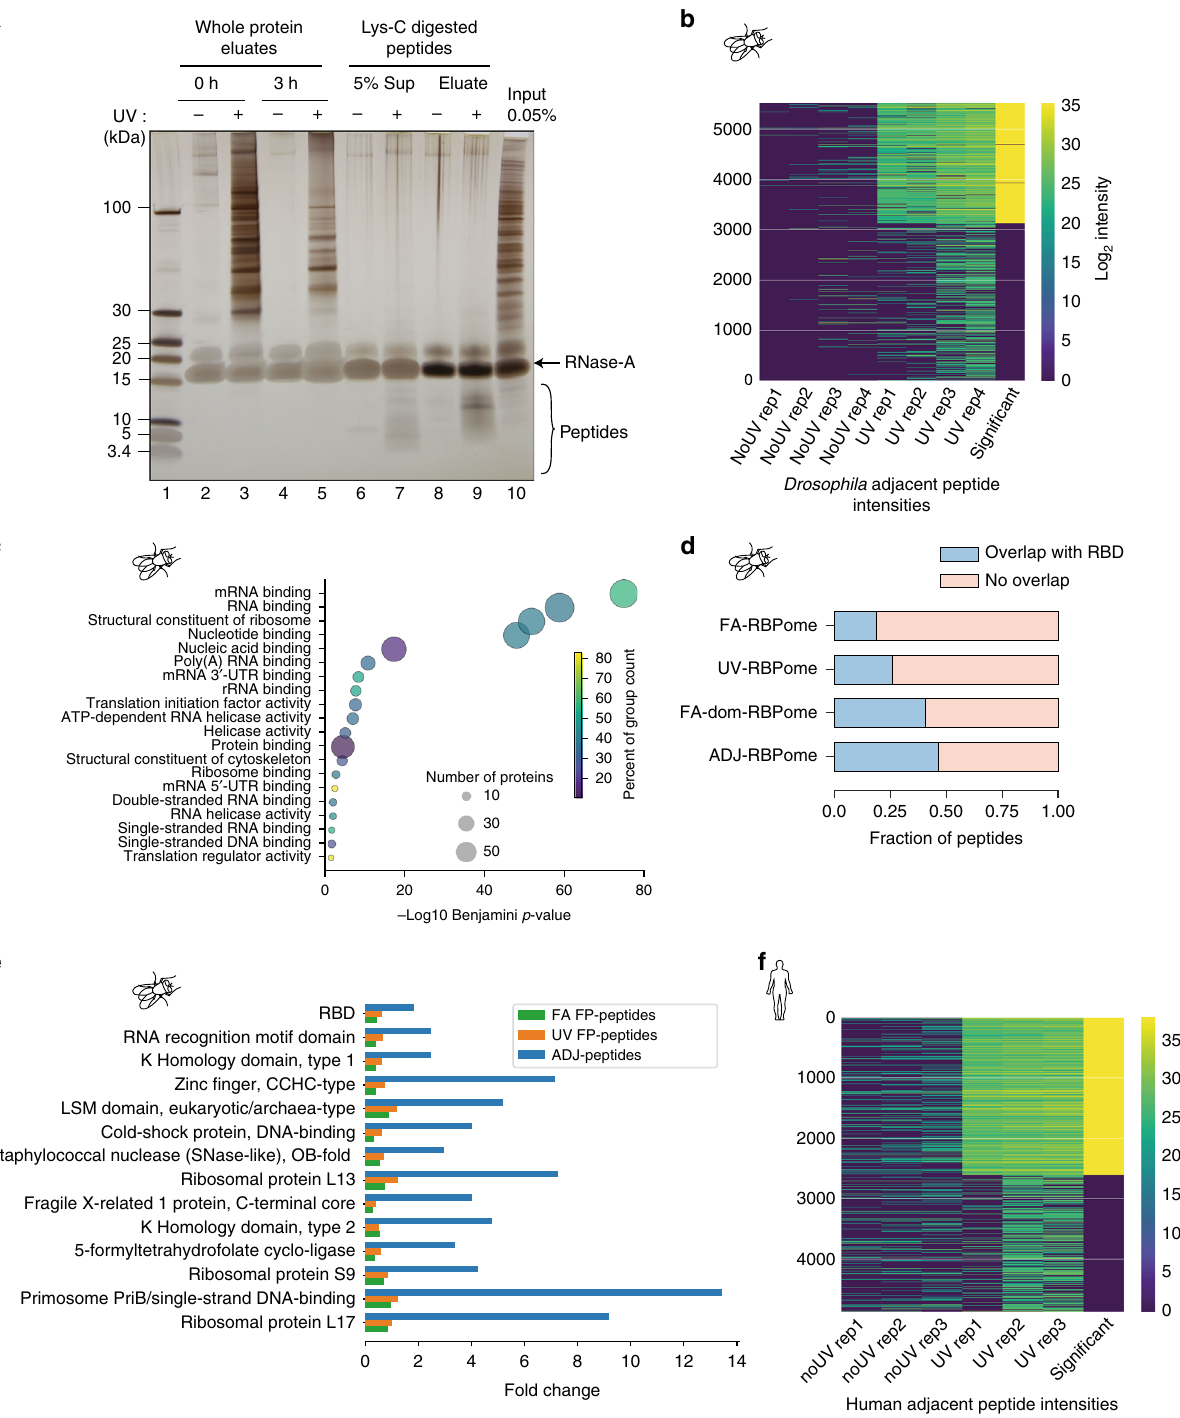
1RNA CCHC-typeK Homology domain, type eukaryotic/archaea-typeZinc finger, DNA-bindingLSM domain, Cold-shock protein, L13Staphylococcal nuclease (SNase-like), OB-fold coreRibosomal protein 2Fragile X-related 1 protein, C-terminal cyclo-ligaseK Homology domain, type S95-formyltetrahydrofolate DNA-bindingRibosomal protein L17Primosome PriB/single-strand protein Fig. 3 Identi fi cation of RBDs by CAPRI. a On-bead digestion of proteins with Lys-C was veri fi ed after RNase-A digestion by silver staining. The lanes are as follows: whole-protein eluates at 0 h and 3 h incubation (lanes 2 – 5); the released peptides following digestion with Lys-C for 3 h (5% of supernatant) and peptides eluted from beads (Elu) for non-crosslinked ( - ) and UV crosslinked ( + ) samples (lanes 6 to 9). b Clustered heatmap of raw intensities (log 2 ) of adjacent peptides detected in the four biological replicates of non-crosslinked and UV-crosslinked samples in Drosophila . Adjacent peptides in UV crosslinked samples were selected by applying a moderated t -test with a Benjamini – Hochberg correction (FDR 5%) and additional fi ltering for an eightfold intensity increase relative to the non-crosslinked samples. Adjacent peptides selected after statistical analysis are depicted in the last lane with maximum intensity. c GO terms (Molecular function) enriched in the Drosophila ADJ-RBPome. d The fraction of ADJ-peptides mapping to canonical RBDs is plotted along with the fraction of full-protein peptides (FP-peptides) mapping to the same domains from the UV- and FA-RBPomes. e Domains enriched in ADJ-peptides compared to FP-peptides from UV- and FA-RBPomes. f Same as b but for three biological replicates in